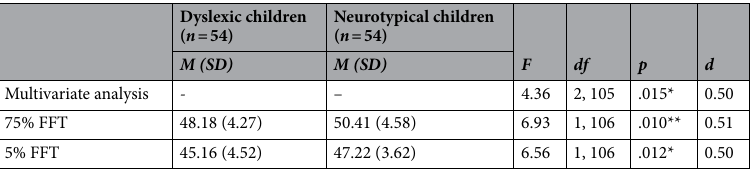
Table 1. Comparison of flicker fusion thresholds in dyslexic and neurotypical children. Bonferroni adjusted alpha level of * p < .016, ** p ≤ .01; Cohen’s d ≥ 0.2, d ≥ 0.5, and d ≥ 0.8, represent small, medium, and large effect sizes,